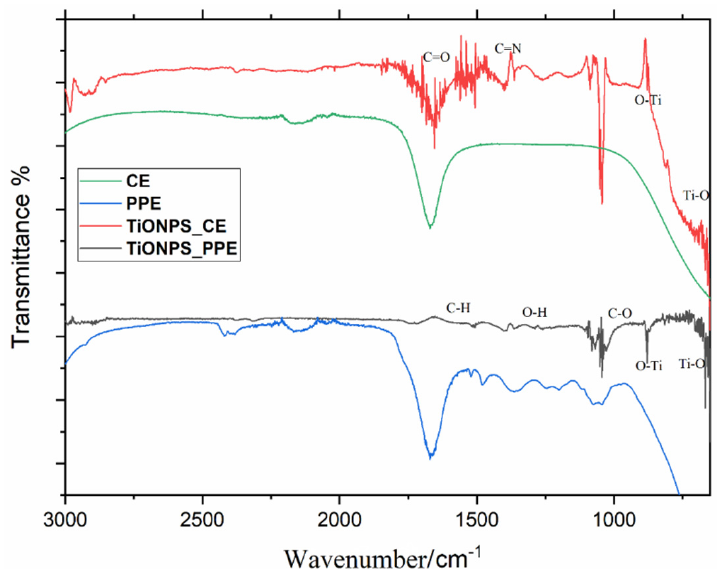
Figure 3. Comparative FTIR spectra of synthesized TiO 2 NPs_PPE and TiO 2 NPs_CE nanoparticles with their standards (PPE and CE).